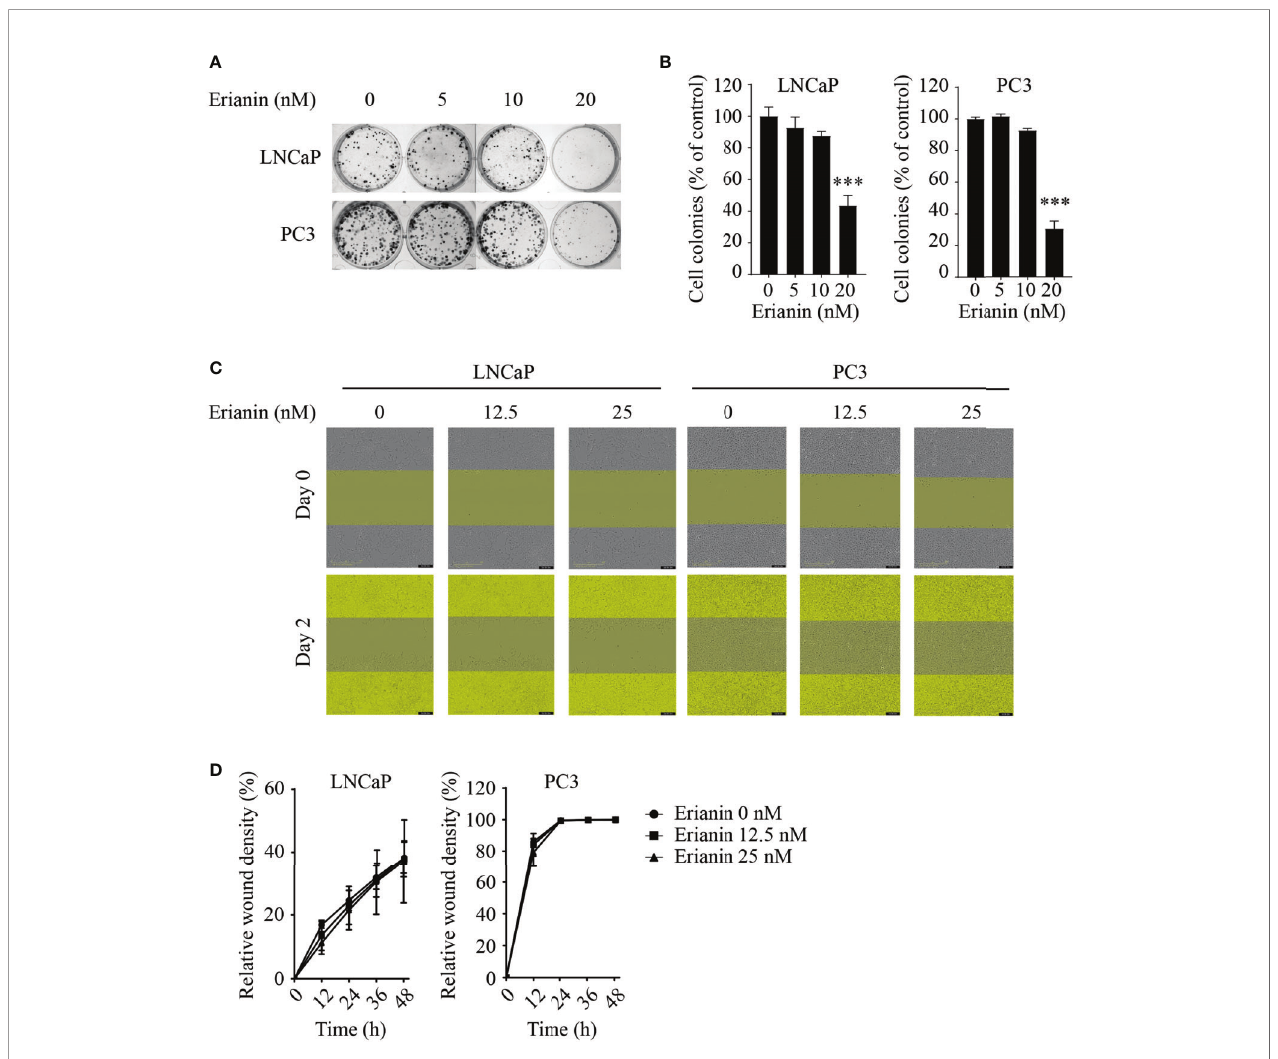
FIGURE 1 | Erianin suppresses colony formation but not migration in both LNCaP and PC3 cells. (A, B) Cells were treated with erianin at indicated concentrations for 10 days. Images are representative of three independent experiments (A) and the number of colonies was quanti fi ed (B) . (C, D) Wound healing assay was performed to assess cell migration. Cells were treated with erianin at indicated concentrations for up to 48 h. Images are representative of three independent experiments (C) and the wound closure area were quanti fi ed (D) . Data are expressed as mean ± SD. n=3. *** p < 0.001, versus untreated